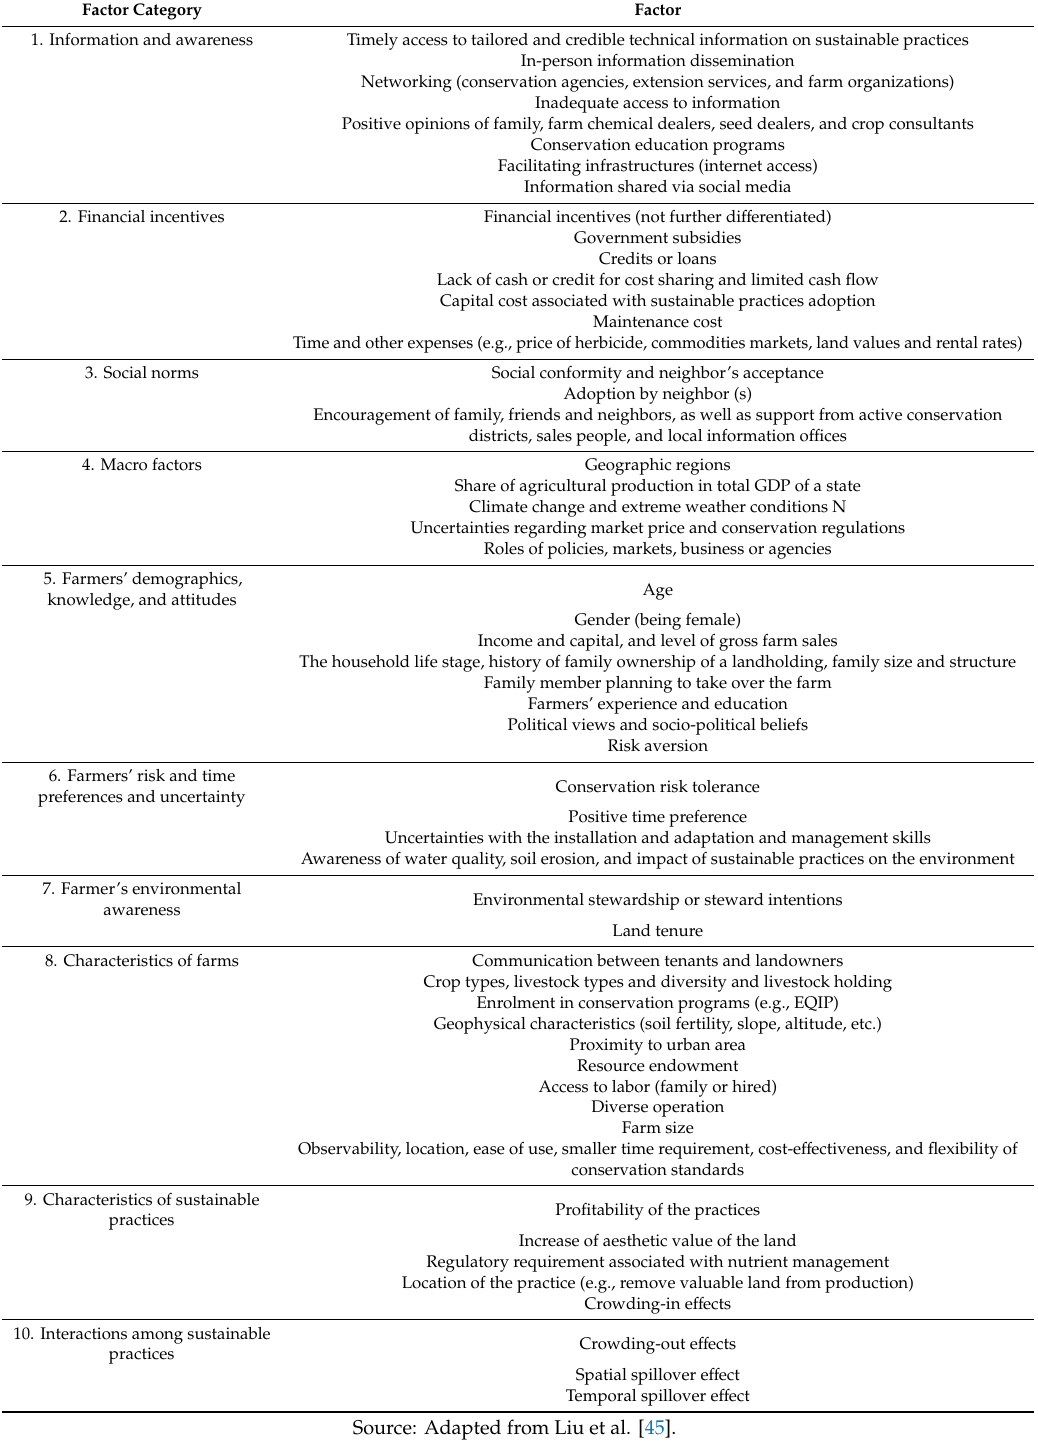
Table 1. Summary of findings on factors influencing the adoption of sustainable practices by